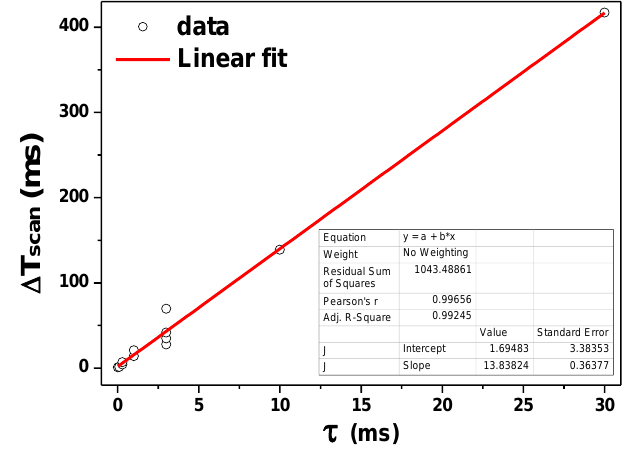
Figure 4. Plot of ΔT scan , vs. time constant  , associated with a linear